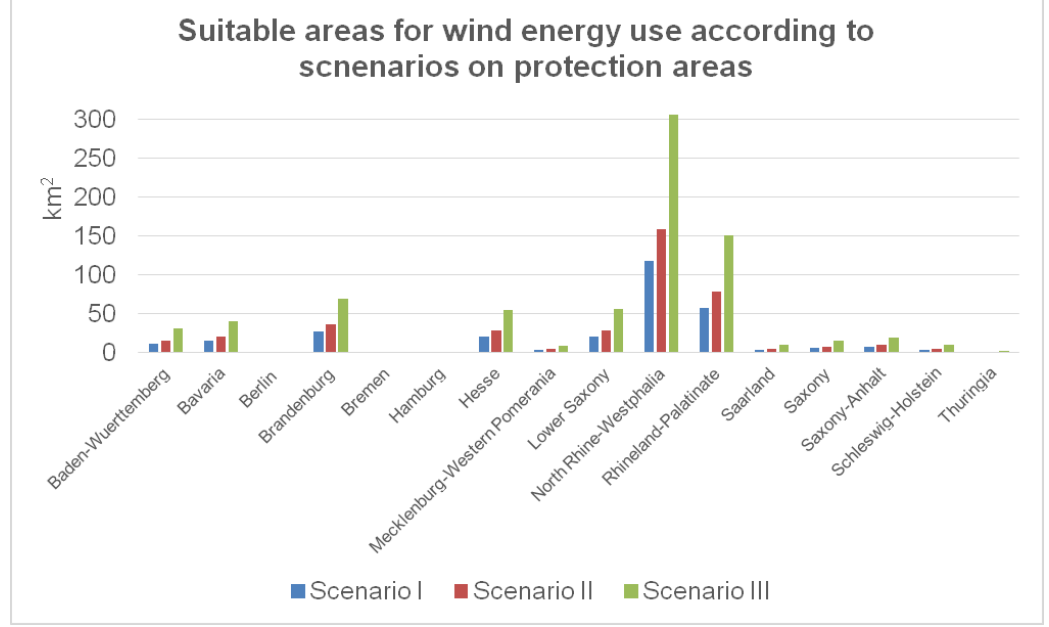
Figure 8. Potential areas according to three future scenarios depending on protection